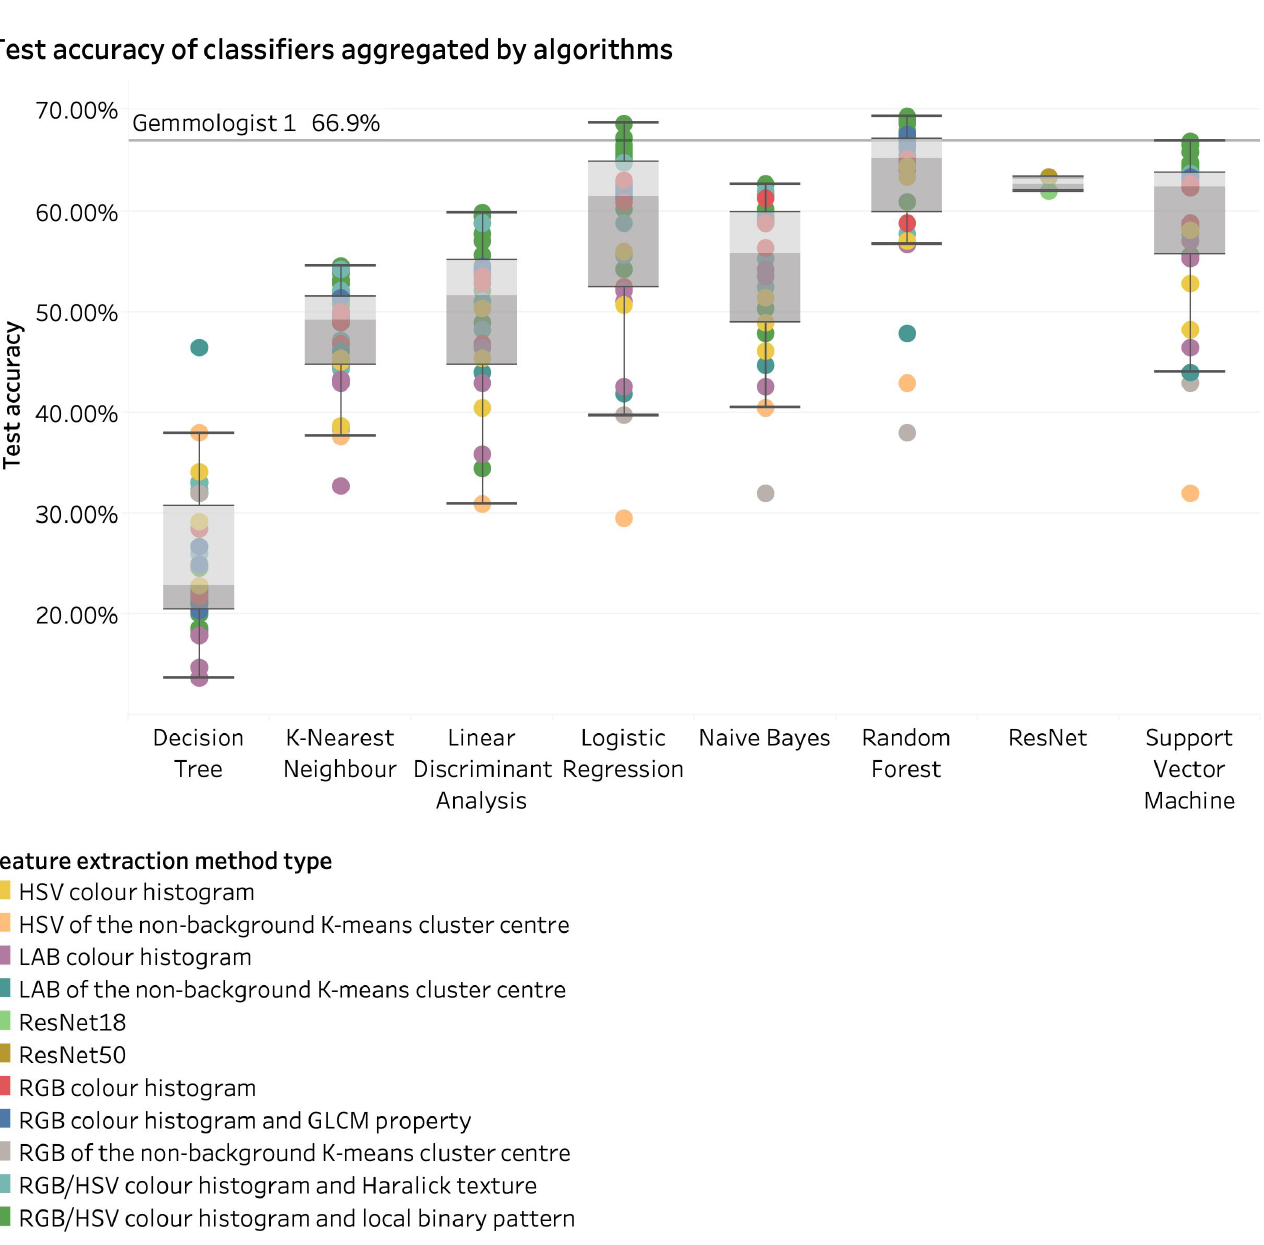
Figure 8. Results of all the combinations of algorithms and feature extraction methodologies grouped by algorithm. Each combination is represented by a coloured circle, and the summary of the distribu- tion per algorithm is displayed as a statistical boxplot (for an explanation, see the text). The most accurate results corresponded to Random Forest and Logistic Regression, both of which surpassed the best gemmologist in the expert